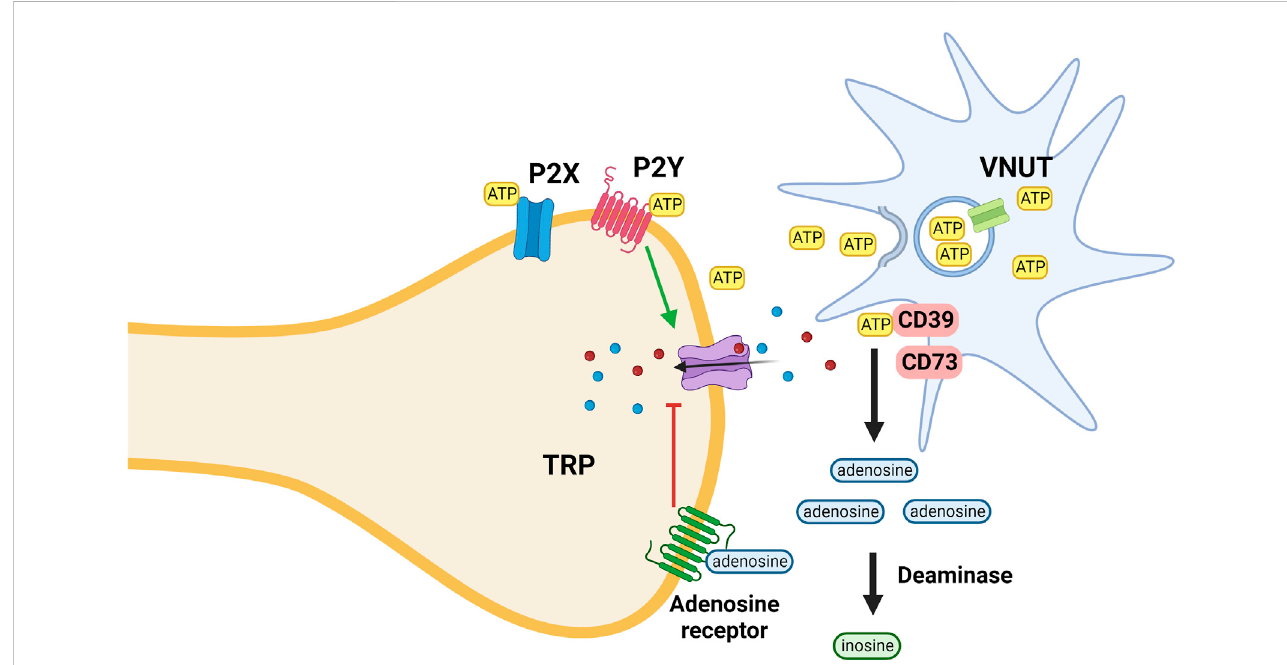
FIGURE 4 ATPisreleasedfrommicroglia,keratinocytesandothercells via theactivityoftheVNUT;inhibitionofthetransporterreducestheATPconcentrationand thus its pro-in fl ammatory effect mediated via interaction with both ionotropic (P2X) and metabotropic (P2Y) purinergic receptors. ATP is metabolized by ectoenzymes (CD; cluster of differentiation 73 and 39). Extracellular adenosine generated by metabolic break-down of nucleotides activates adenosine receptors that decrease the sodium and calcium permeability of TRP receptors. Adenosine is metabolized by deaminases.